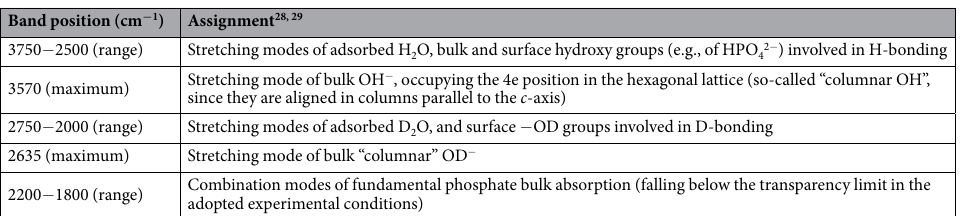
Table 2. General assignment of bands present in the 3800 − 1800 cm − 1 range of the IR spectra of Cit − HA − 4 h, Cit − HA − 24 h; Cit − HA − 96 h in contact with 20 mbar of H 2 O, after 60 min outgassing at b.t., and after exchange with D 2 O and subsequent outgassing at